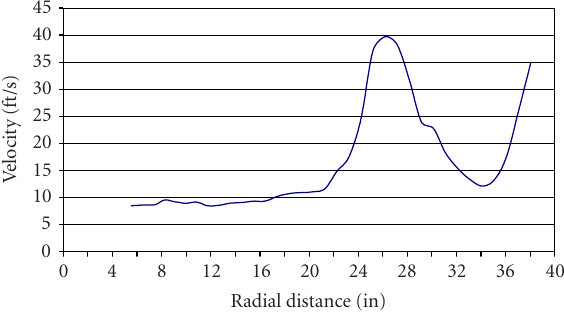
Figure 2: Fan discharge velocity profile as a function of radial dis- tance along the fan